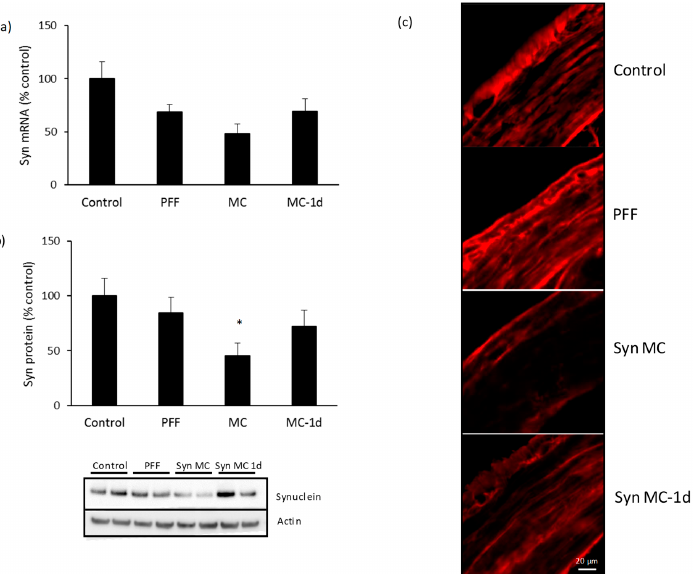
Figure 6. Alpha-synuclein downregulation in intestine of mice treated with anti-alpha-synuclein shRNA-MC RVG-EV after the development of alpha-synuclein pathology. Analyses of alpha-synu- clein mRNA expression ( a ) and protein levels ( b ) normalized to actin. Typical western blot is shown. ( c ) Immuno fl uorescence images of total alpha-synuclein in intestine sections. Scale bar represents 20 µm. Values are expressed as mean ± SEM ( n = 5). * p < 0.05, non-parametric Kruskal–Wallis test.